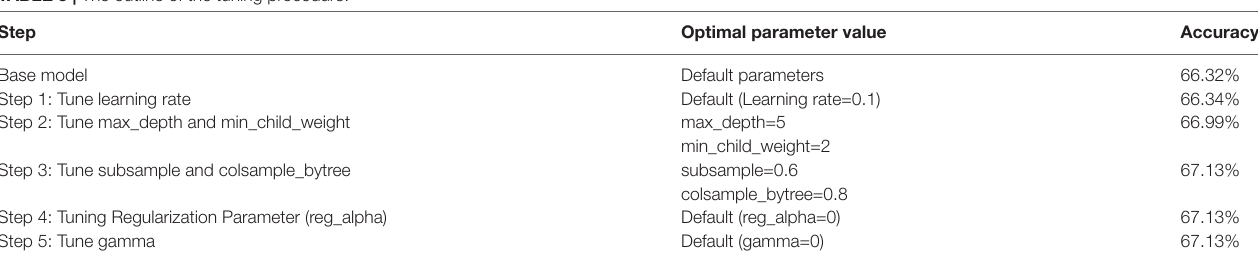
TABLE 3 | The outline of the tuning